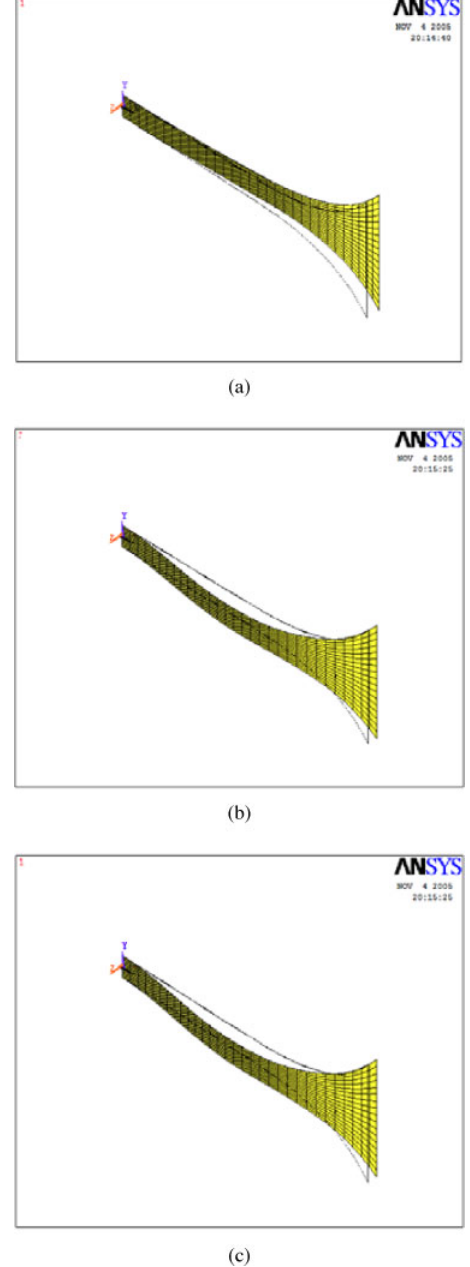
Figure 13 Deflection of three order mode shapes: (a) mode shape in first order; (b) mode shape in second order; and (c) mode shape in third